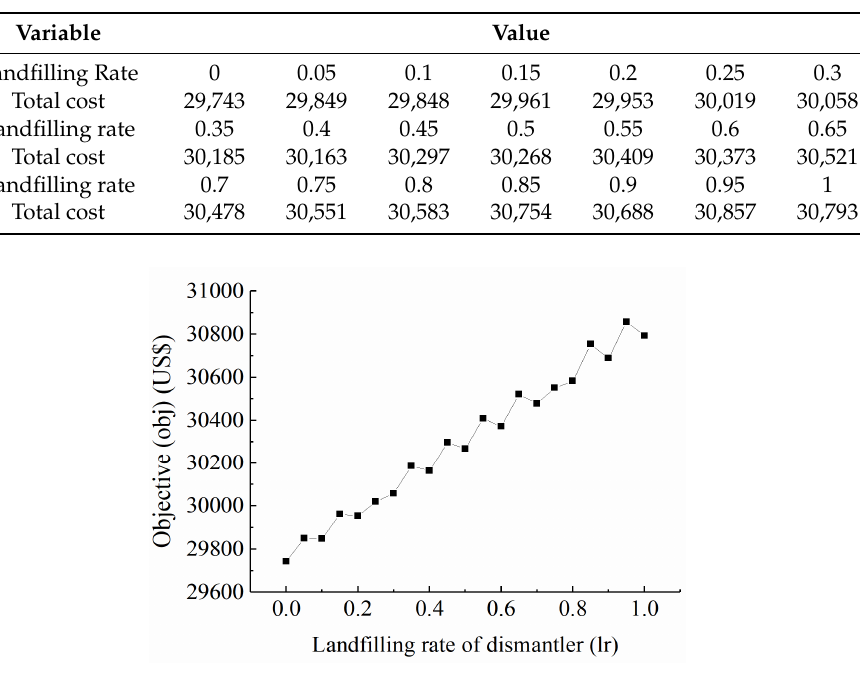
Table 5. The relationship between landfilling rate and total cost.